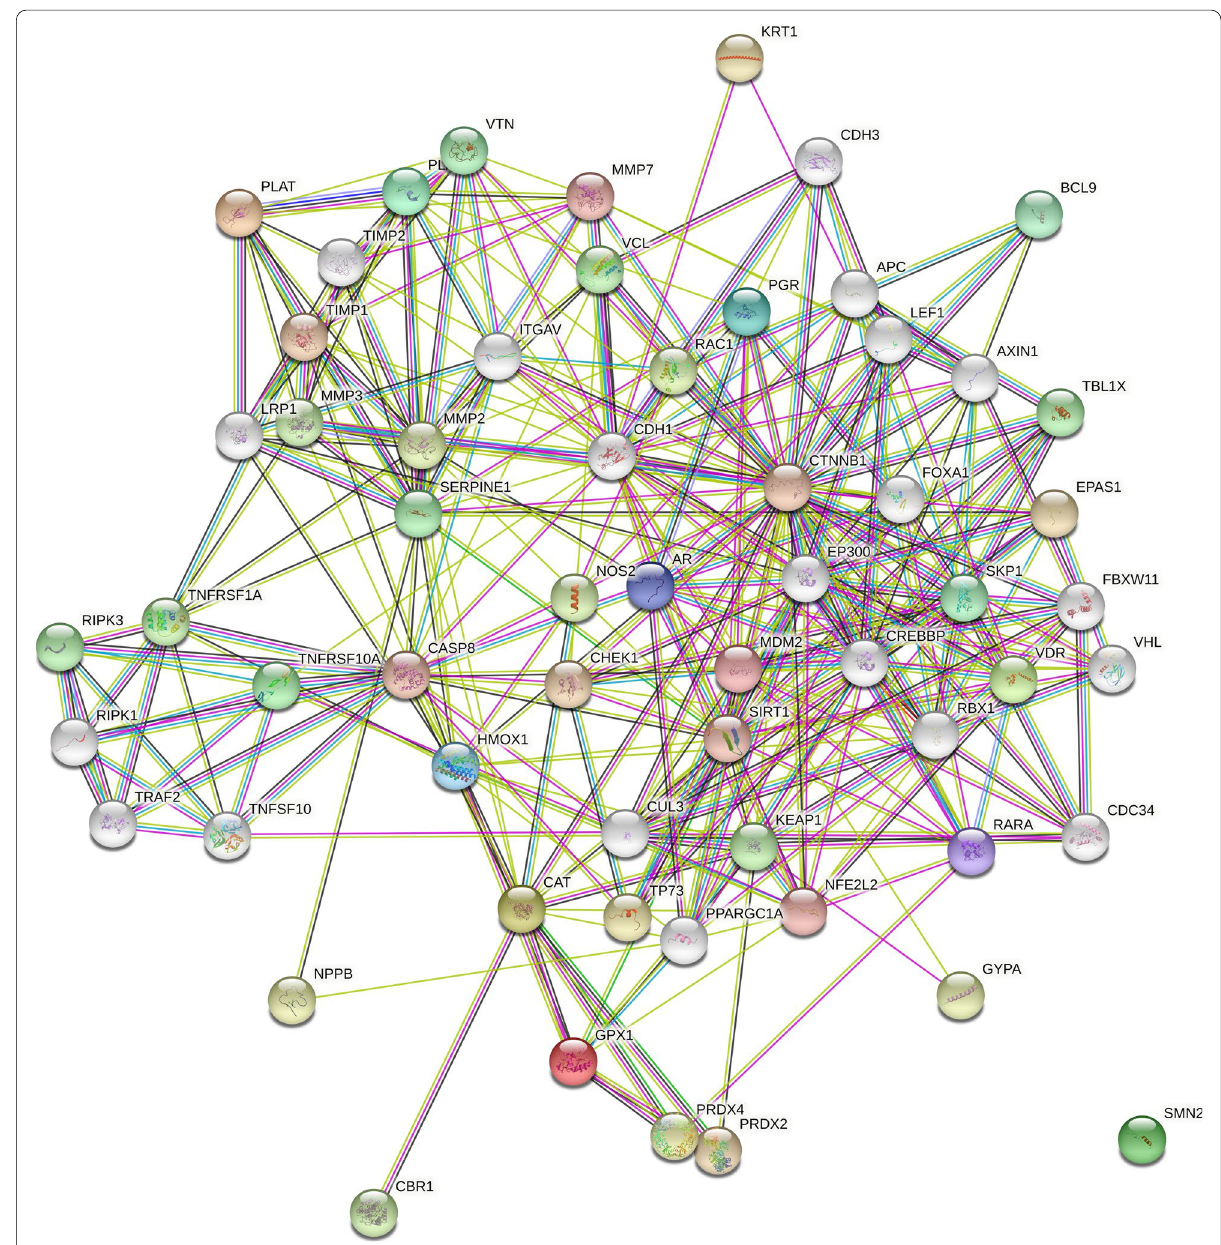
Fig. 1 Protein-protein interaction of regulated